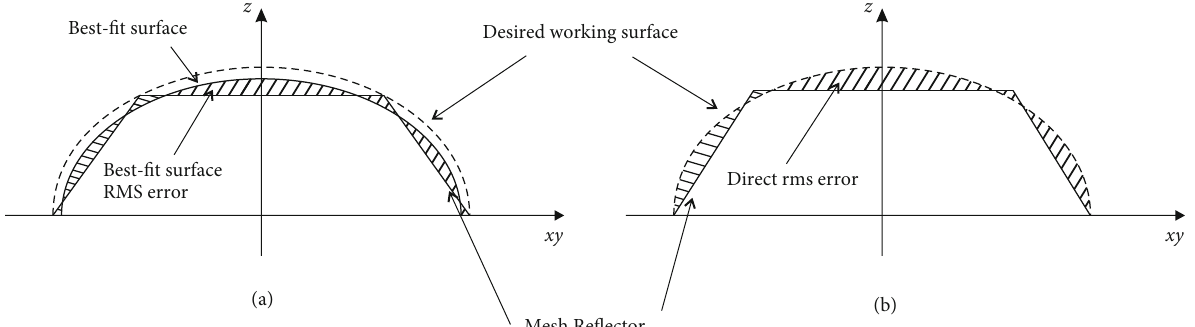
Figure 10: Comparison of two types of RMS errors: (a) the best- fi t surface RMS error and (b) the direct RMS